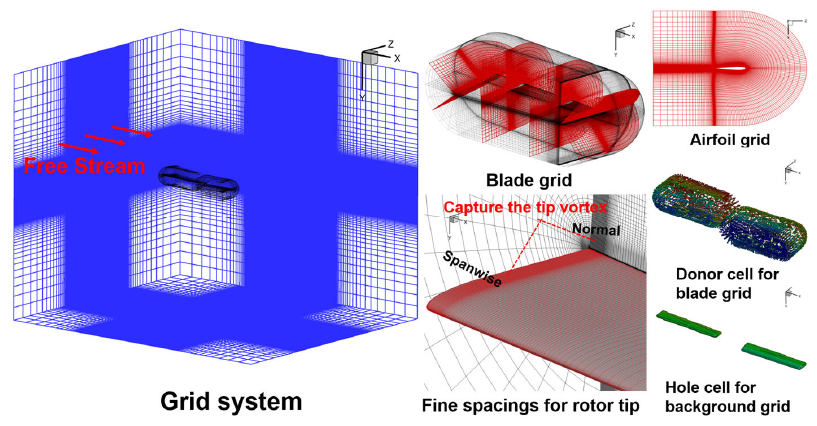
Figure 1. Moving overset grid system of the OLS rotor.